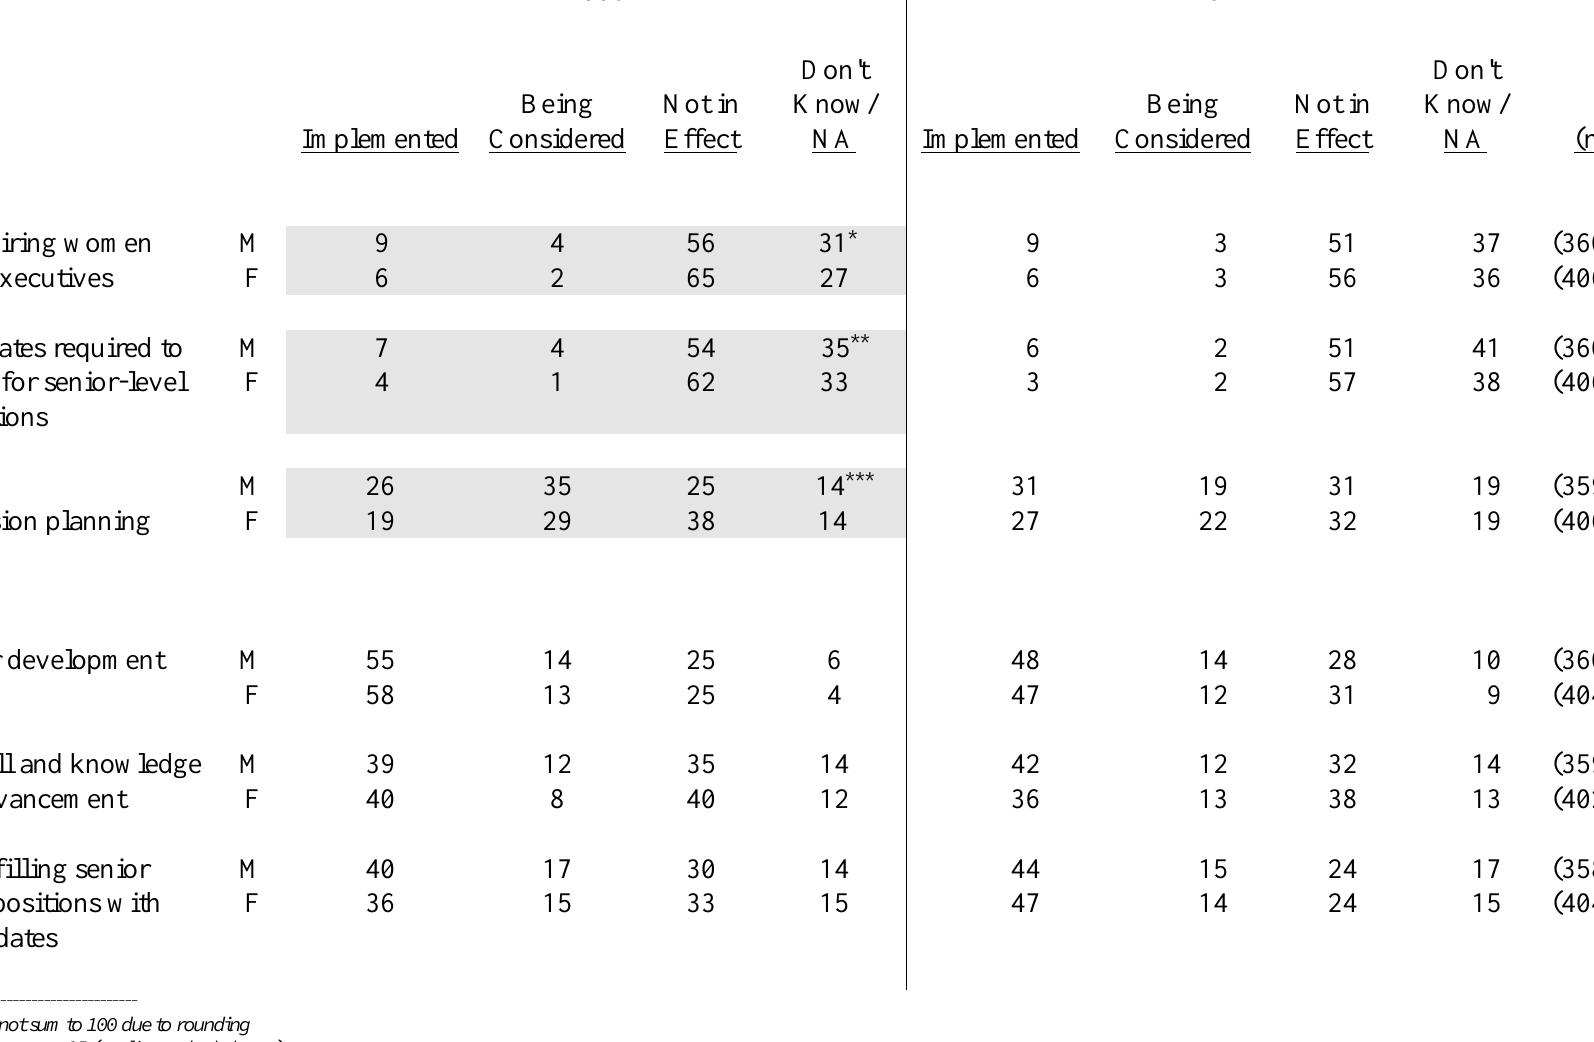
Table 24. Organization’s Initiatives (row percent)